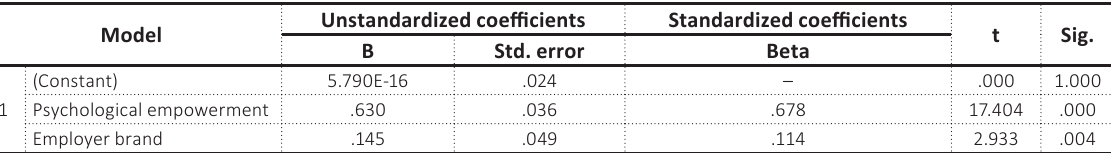
Table 3. Multiple linear regression model of the influence of psychological empowerment and employer brand on employee engagement